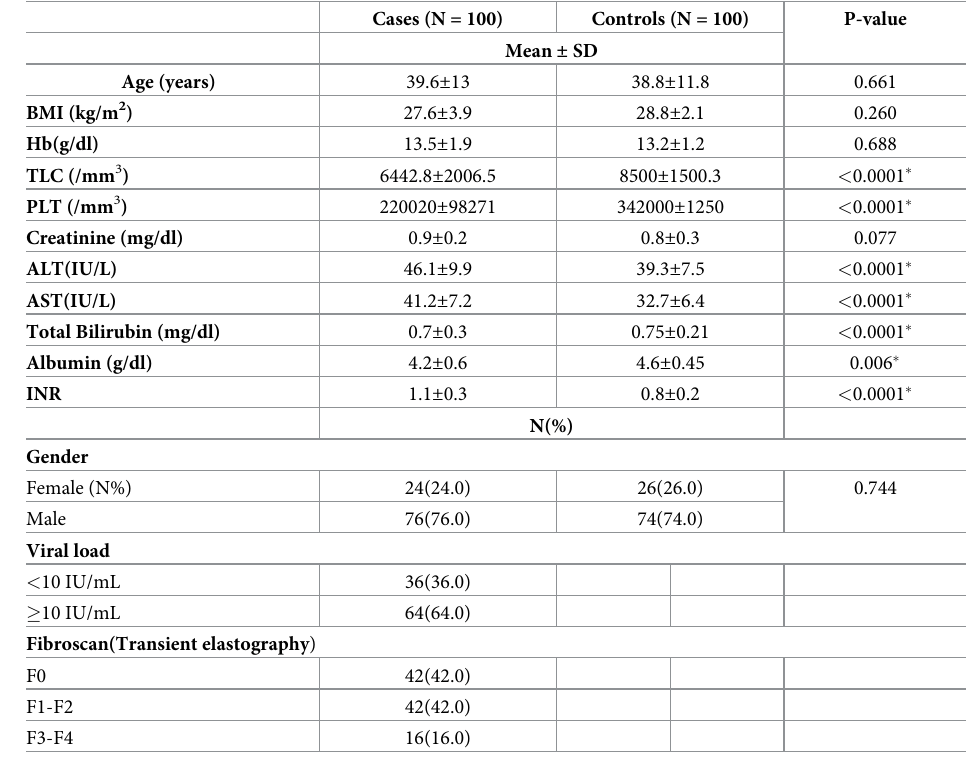
Table 1. Basic and clinical characteristics of study